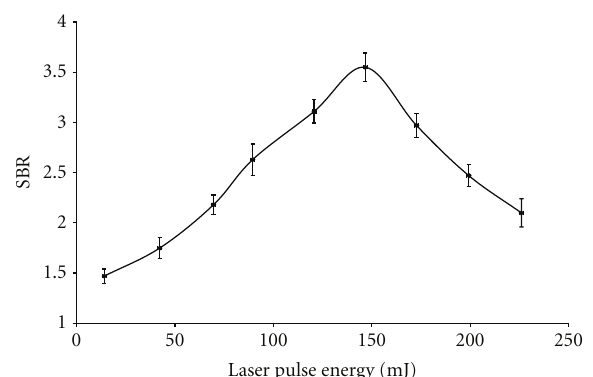
Figure 4: Signal intensity (SBR) of chromium (427.481 nm) versus laser energy (mJ). Error bars denote the 95% confidence level and are based on replicate (10) measurements.